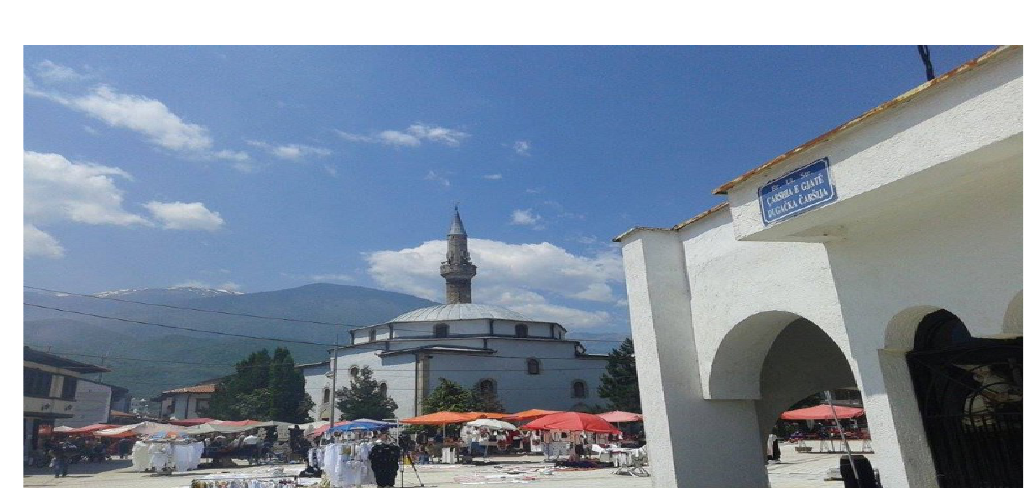
Fig. 2. Mosque Kurshumli (Municipality of Peja,